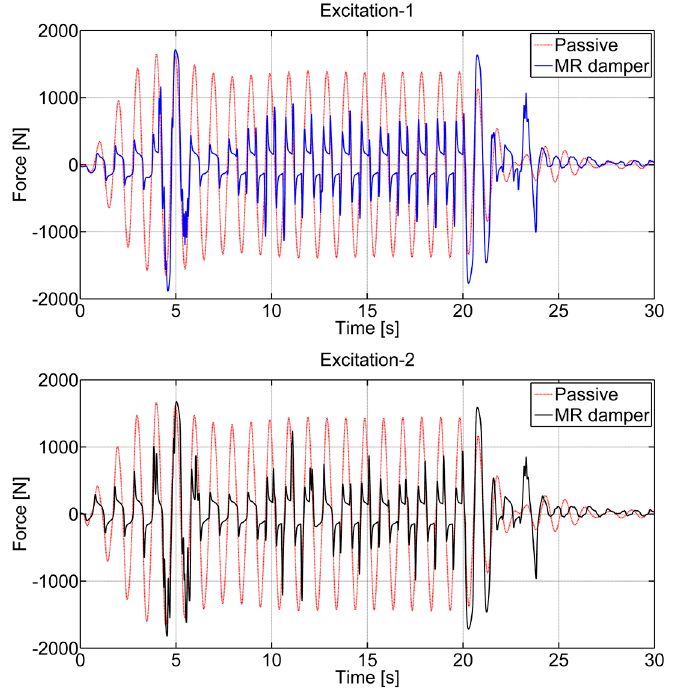
Figure 13. The TMD 0.0300 damping forces and the MR damper forces in STMDh ∞ 0.0300 : Excitation-1 Figure 13. The TMD (cid:2868).(cid:2868)(cid:2871)(cid:2868)(cid:2868) damping forces and the MR damper forces in STMDh∞ (cid:2868).(cid:2868)(cid:2871)(cid:2868)(cid:2868) : Excitation-1 (top); Excitation-2 Figure 13. The TMD (cid:2868).(cid:2868)(cid:2871)(cid:2868)(cid:2868) damping forces and the MR damper forces in STMDh∞ (cid:2868).(cid:2868)(cid:2871)(cid:2868)(cid:2868) : Excitation-1 (top); Excitation-2 (bottom). (top); Excitation-2 (bottom).